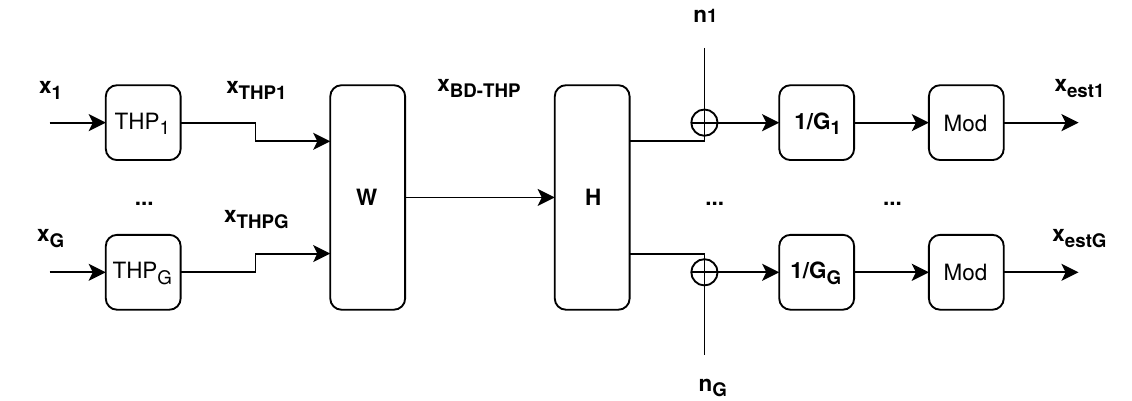
Figure 3. Hybrid precoder block scheme